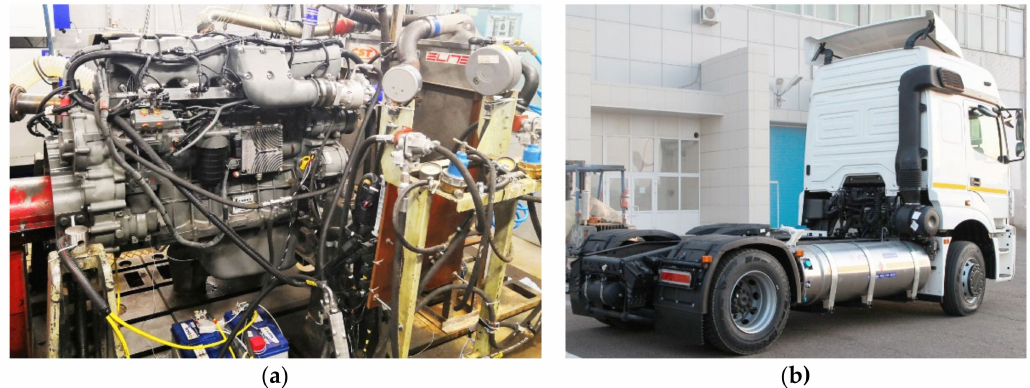
Figure 1. The developed gas engine at a test bench ( a ) and a heavy-duty (HD) vehicle equipped with the developed liquefied gas system ( b